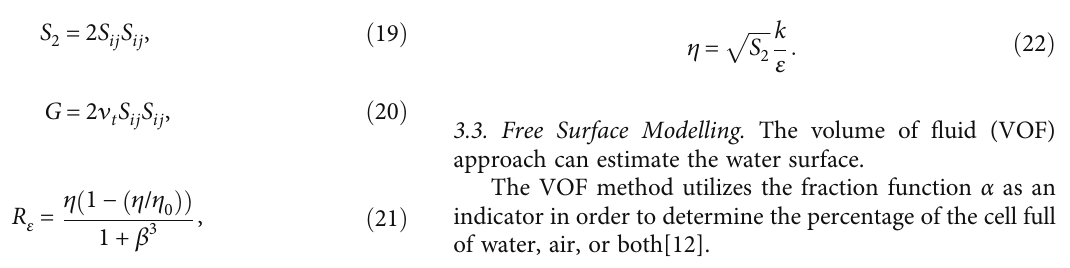
Figure 6: The maximum height as a function of the number for the three-tested